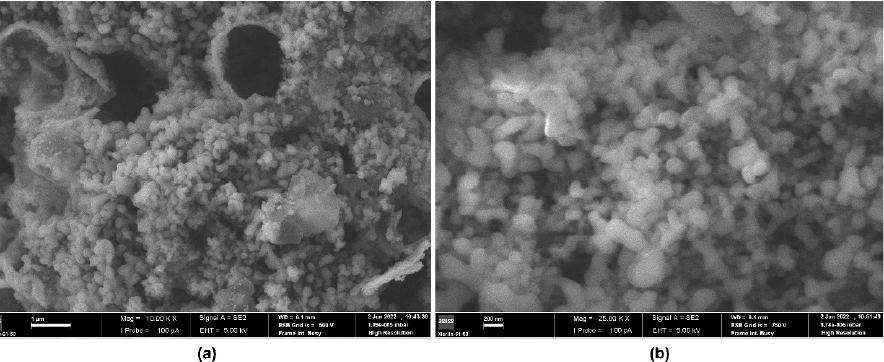
Figure 2. SEM images of freeze-dried CUR-[BMPYRR][NTf 2 ]@ncSi. Scale Bars: ( a ) 1 μ m; and ( b ) 200 nm.